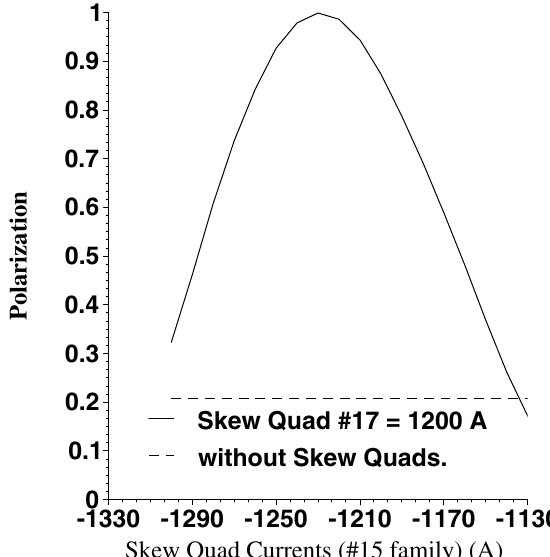
FIG. 10. Polarization after crossing the 36 (cid:5) (cid:28) with fixed normal mode tunes ( (cid:28) currents for hypothetical skew quadrupoles in the 15th lattice sections. The 17th skew quadrupole family was fixed at a current of 1200 A. The dashed line indicates base polarization without any skew quadrupoles operating.